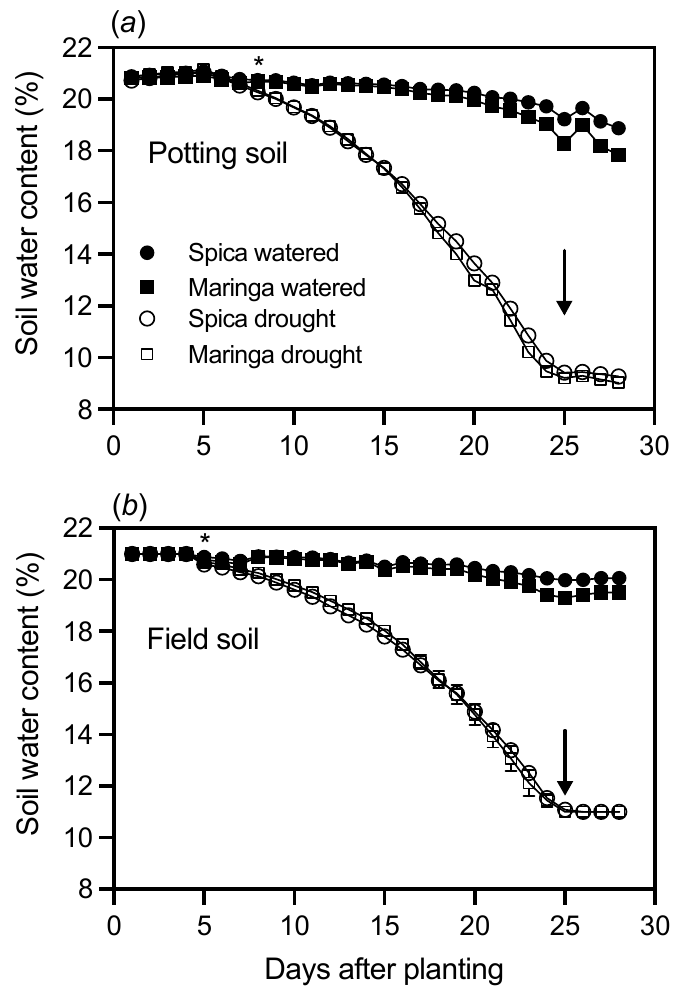
Figure 2. Effect of drought on water content of two soil types in which wheat genotypes of contrasting root morphologies were grown. Watered treatments are denoted by filled symbols and drought treatments by empty symbols, with circles representing pots sown with Spica and squares pots sown with Maringa containing ( a ) potting soil and ( b ) field soil. Where values for Spica and Maringa were sufficiently similar that they overlapped, the symbols representing Spica obscured those representing Maringa. For the drought treatment, after soils were set to their initial water content, they were allowed to deplete until they reached a minimum as denoted by the arrows, after which soil water content was maintained. For watered treatments, the soil water content was maintained daily. Bars denote ± SE of the mean of either four (field soil) or five (potting soil) replicates and are not visible if they are smaller than the symbol. The asterisk denotes the first day where a significant difference ( p < 0.05) became apparent between watered and droughted pots when data were analyzed with a Student’s t -test. Thereafter, the watered and droughted treatments remained significantly different from one another with p < 0.001 by day 7 for field soil and by day 8 for potting soil. Maringa produced more shoot biomass and tillers than Spica for the watered treatment of both the potting and field soils (Figure 3a,b). Drought treatment reduced shoot biomass and number of tillers for both genotypes grown in both soils compared to the watered treatments. Water use efficiency, expressed as the amount of shoot biomass produced per unit of water taken up, was the same for both genotypes when grown under watered conditions in both soils (Figure 3c). However, when droughted, Maringa was more water efficient than Spica regardless of the soil